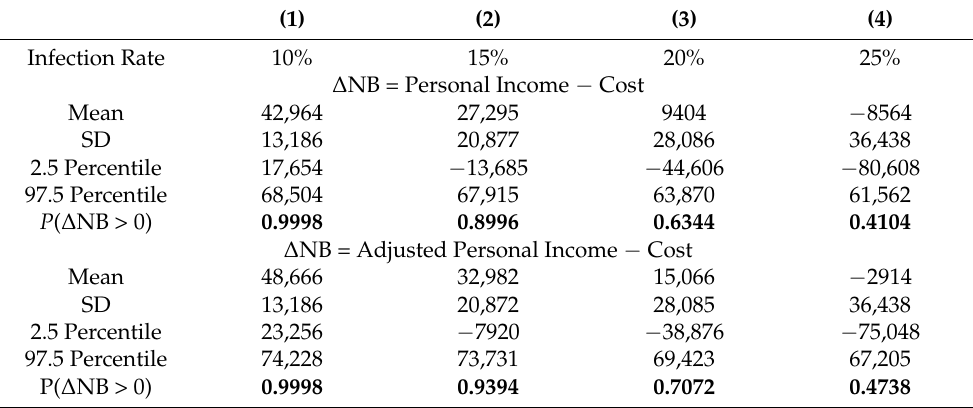
Table 3. Summary statistics (in dollars) of the ∆ NB distributions for Florida.